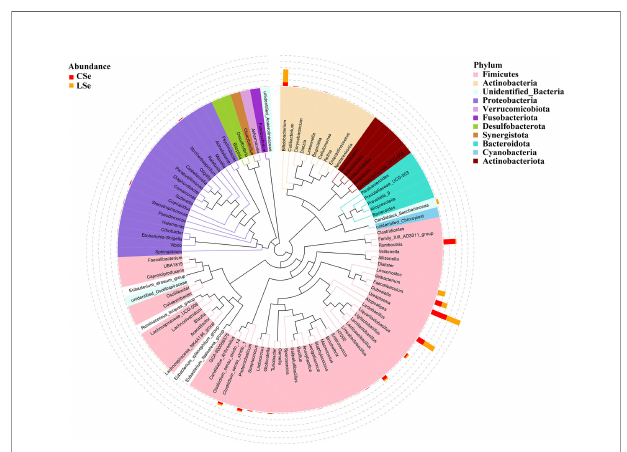
FIGURE 3 | Phylogenetic tree analysis of genus level species.